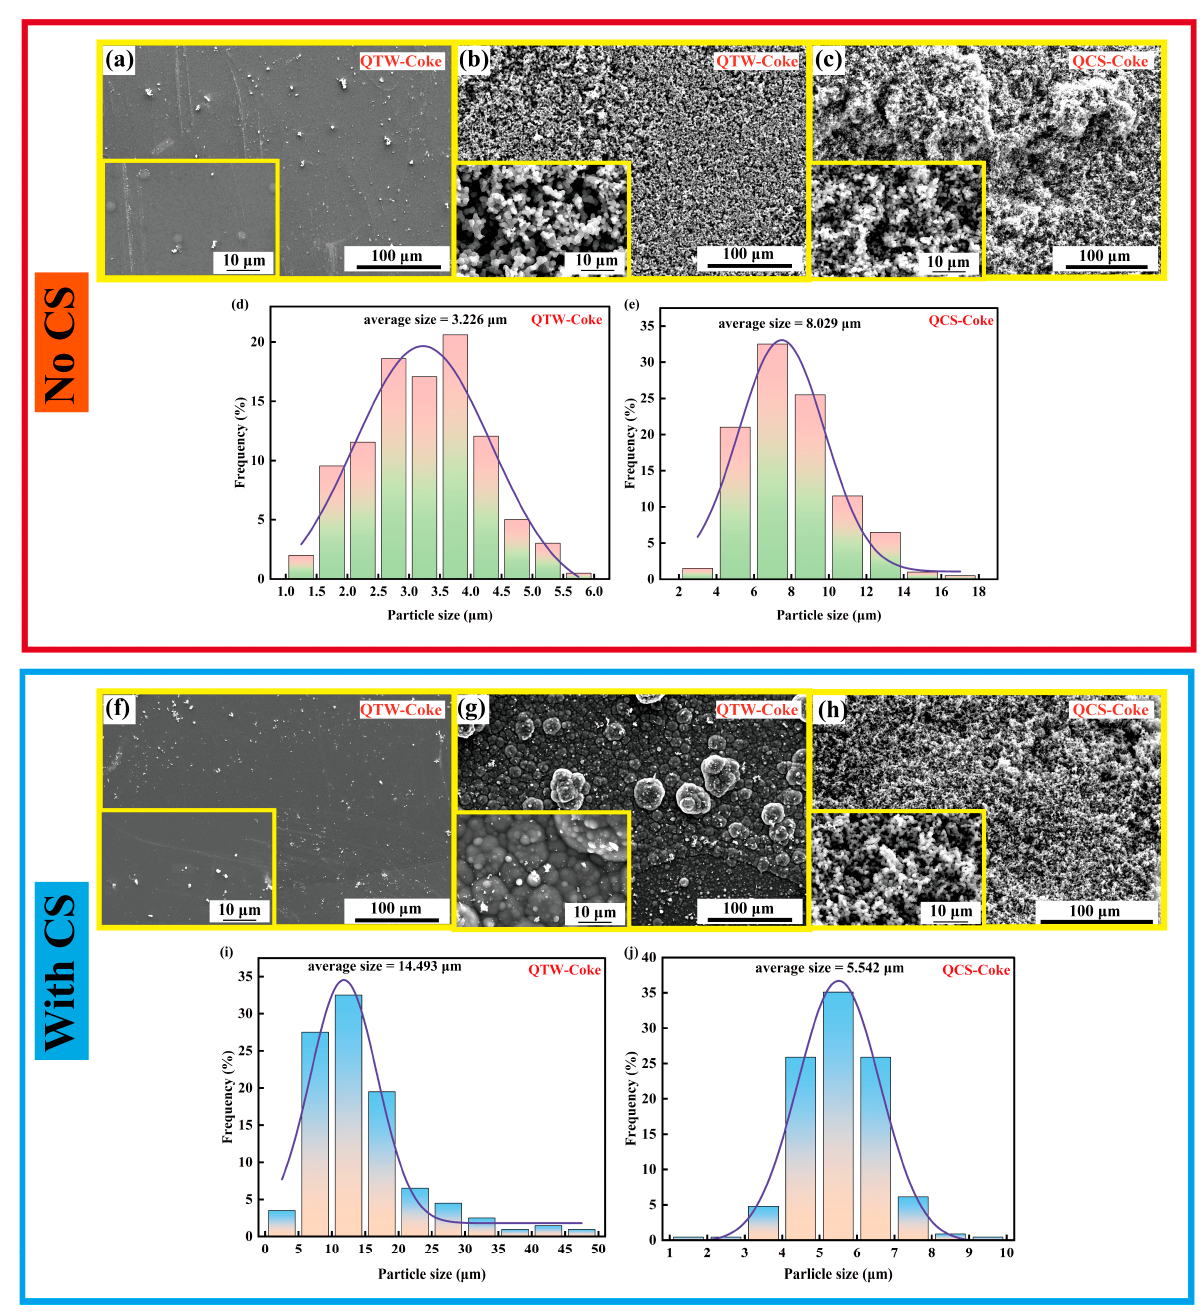
Figure 7. ( a – c , f – h ) SEM images of QTW-Coke and QCS-Coke at 1000 °C; ( d , e , i , j ) Particle size distri- bution of QTW-Coke and QCS-Coke at 1000 °C. distribution of QTW-Coke and QCS-Coke at 1000 ◦